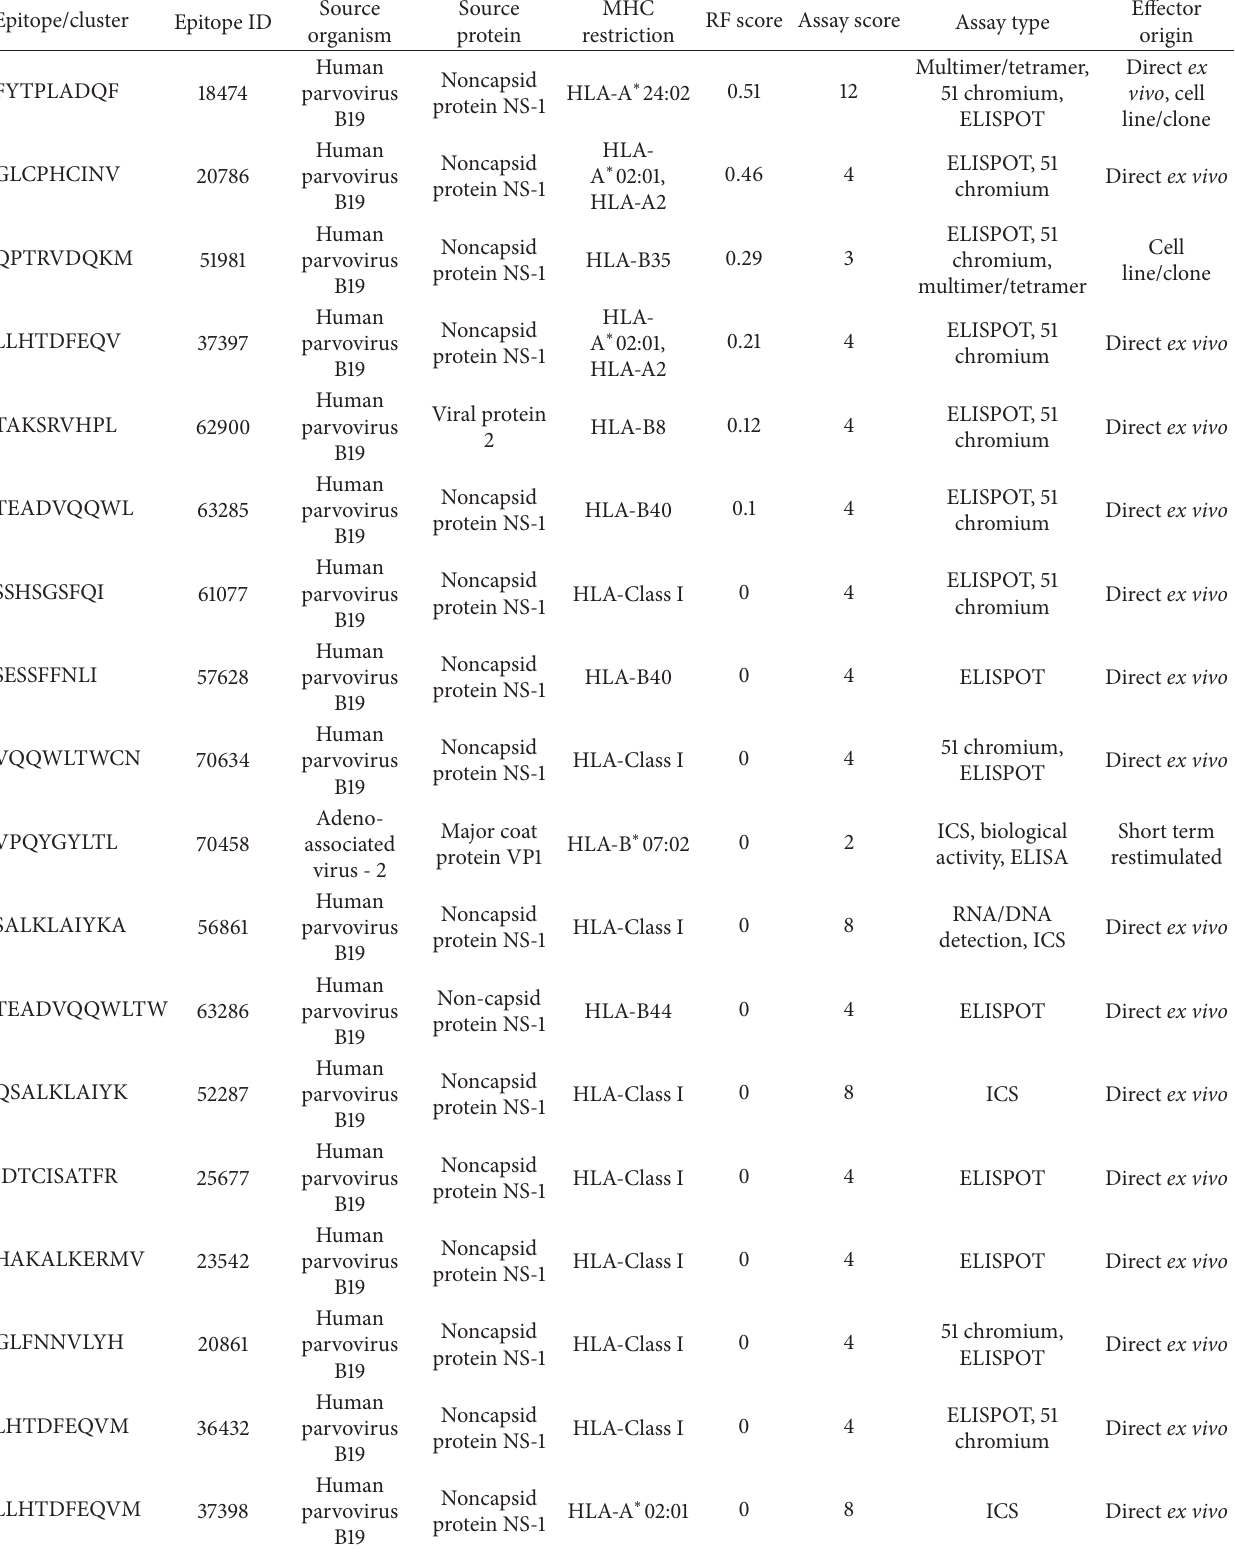
Table 3: Parvoviridae virus validated epitope set downloaded from the web